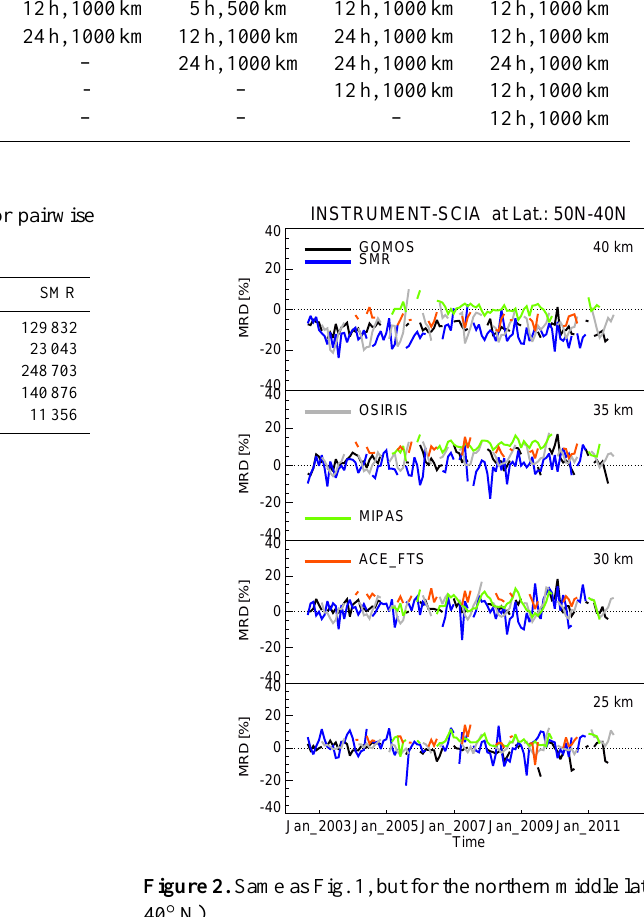
Table 2. Collocation criteria in time (hours) and distance (km). Pairs SCIA GOMOS OSIRIS MIPAS ACE SMR SCIAMACHY